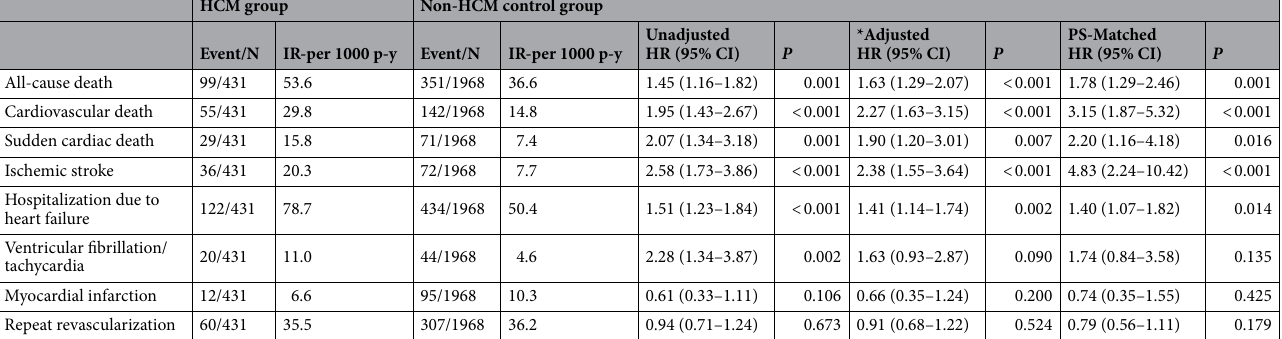
Table 2. Incidence and risk of clinical outcomes. *Multivariable Cox regression model included age, sex, low income, revascularization due to acute MI, revascularization after coronary CT angiography, hypertension, diabetes mellitus, dyslipidemia, atrial fibrillation, previous stroke, and congestive heart failure. Abbreviations: CI, confidence interval; CT, computed tomography; HCM, hypertrophic cardiomyopathy; HR, hazard ratio; IR, incidence rate; MI, myocardial infarction; PS, propensity score; p-y-person-years; VF, ventricular fibrillation; VT, ventricular